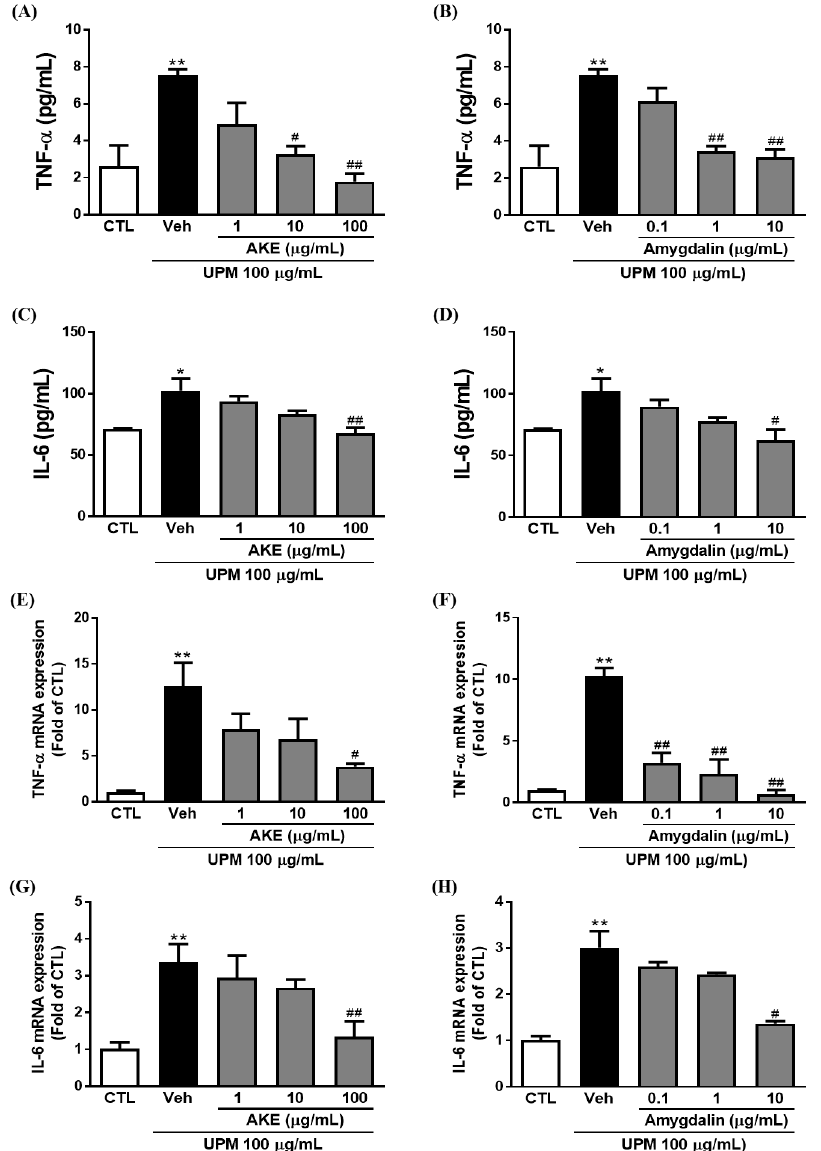
Figure 6. Effects of AKE on inflammation induced by UPM in conjunctival epithelial cells. Conjunctival cells were treated with AKE or amygdalin 1 h before UPM exposure. ( A – D ) The amount of TNF- α or IL-6 released. ( E – H ) mRNA expression of TNF- α or IL-6. Control group: CTL; vehicle group: Veh; apricot kernel extract-treated group: AKE; urban particulate matter-treated group: UPM. Data shown are mean ± standard error of the mean (n ≥ 3). * p < 0.05 or ** p < 0.01 vs. CTL, # p < 0.05 or ## p < 0.01 vs. Veh.